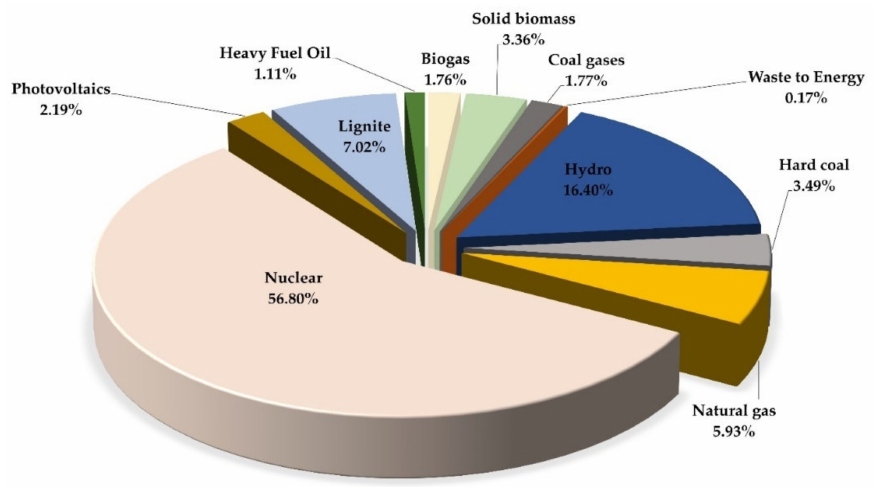
Figure 4. Electricity mix for Slovakia (2021). (Source: GaBi 8.0